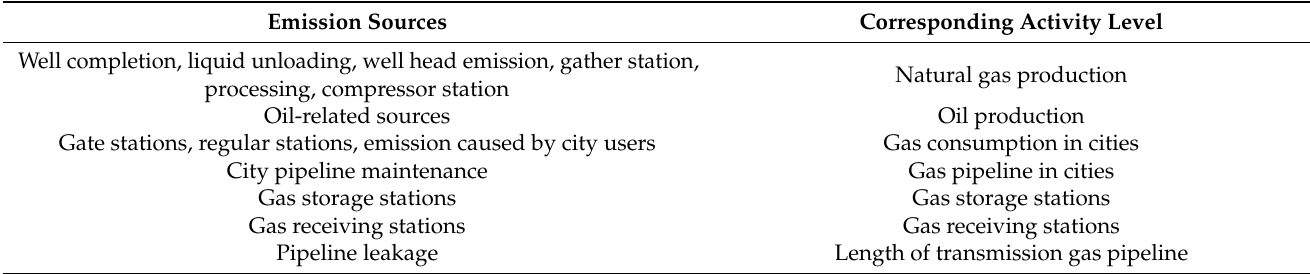
Table 1. Emission sources and the corresponding activity level. The latter is used to estimate the number of the emission